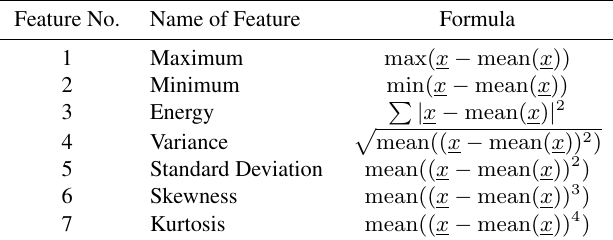
Table 3. Seven features extracted from the GBR time-series data. x represents one data sample of 0 . 5s